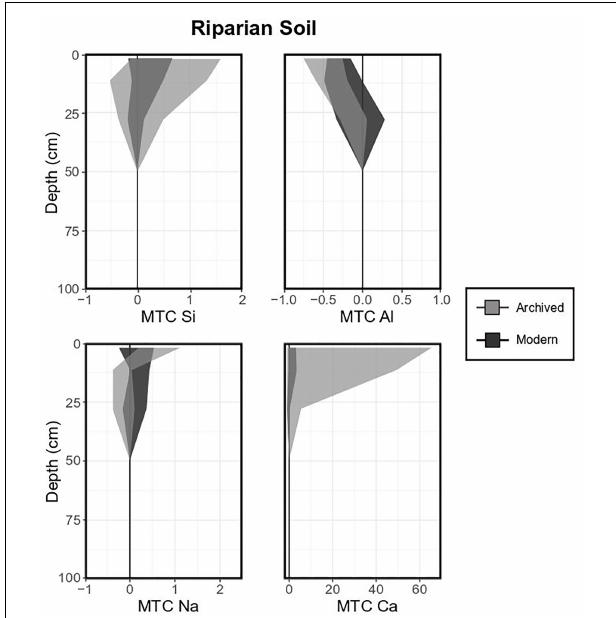
FIGURE 7 | Mass transfer coefficient (MTC) values of selected elements for a typical base of the hill soil (Histosol). Light gray shaded areas indicate standard deviations of means for each element measured in archived samples (1996, 11 pits), dark gray shaded areas indicate standard deviations of means for each element of modern samples (2017, 3